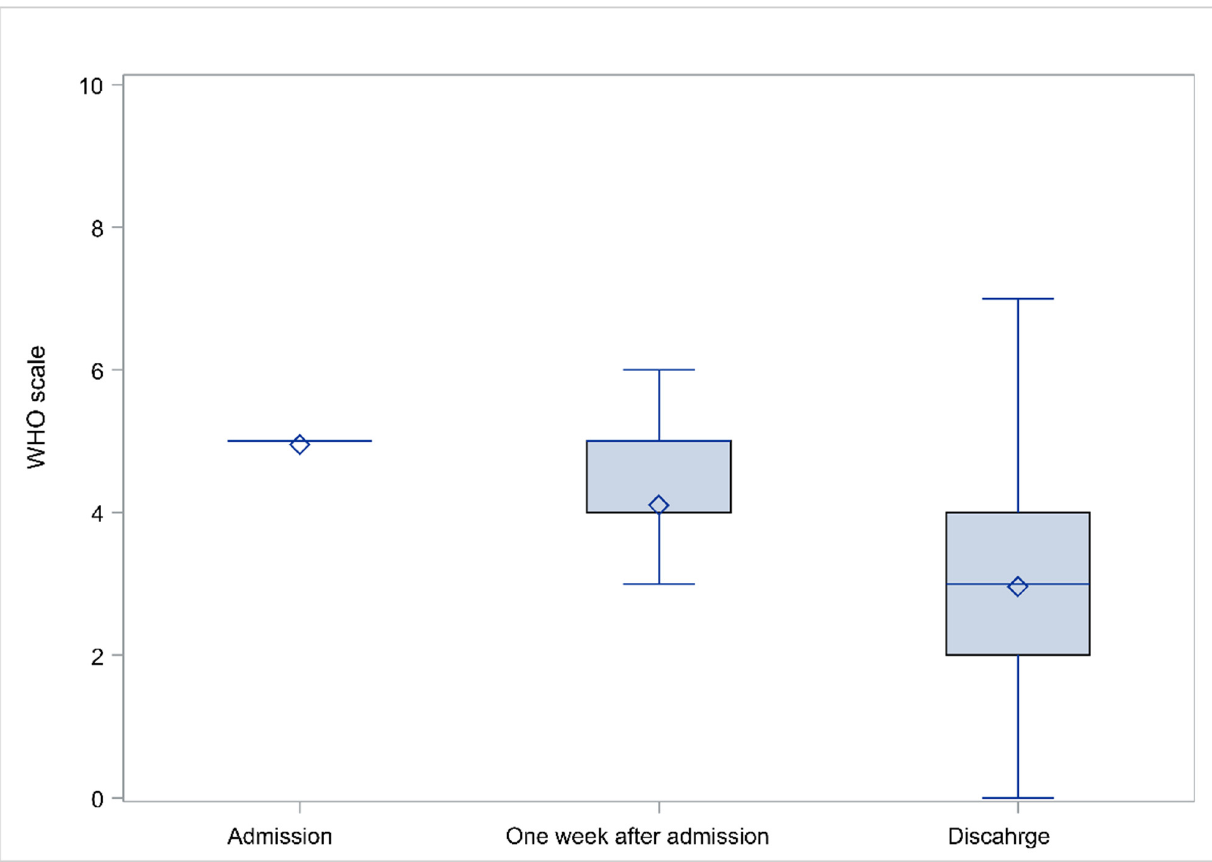
Figure 2. Evolution of patients’ health status from admission to discharge, as it is reflected by the WHO scale. In each plot the lower and upper part of the boxes represent the Q1 and Q3 values; horizontal lines within the boxes represent the median values; the whisker limits correspond to the lower and upper value after excluding outliers; and the diamond symbols represent the mean value. Outliers are not presented.